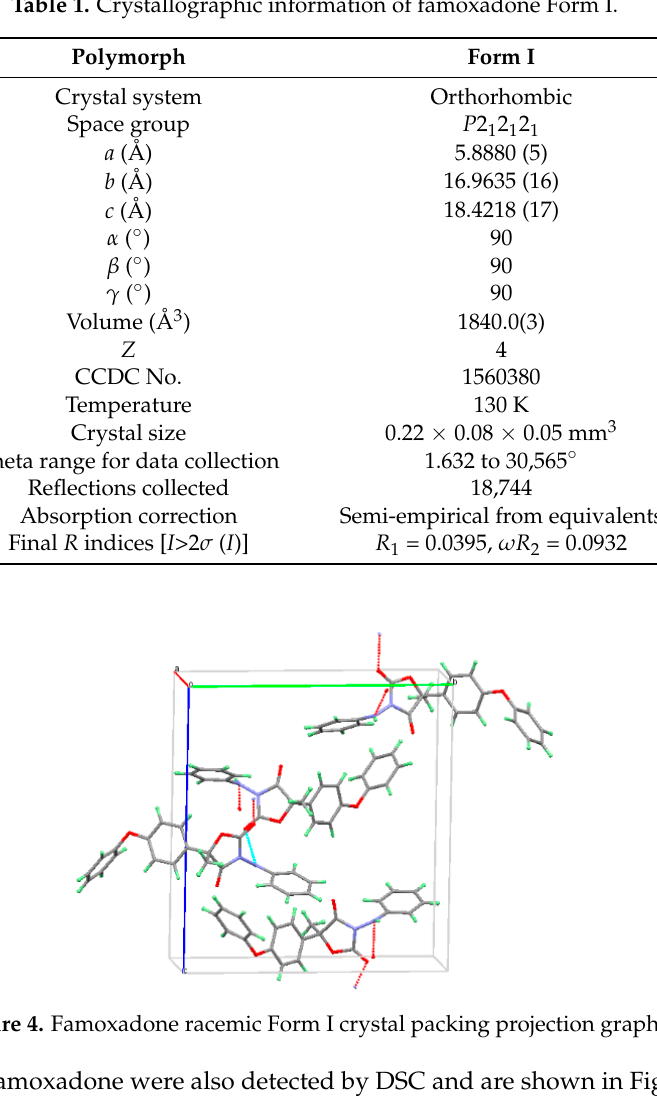
Figure 5. DSC curves of famoxadone from Form I to Form Ⅵ . Table 2. Melting data of famoxadone polymorphs. Polymorph